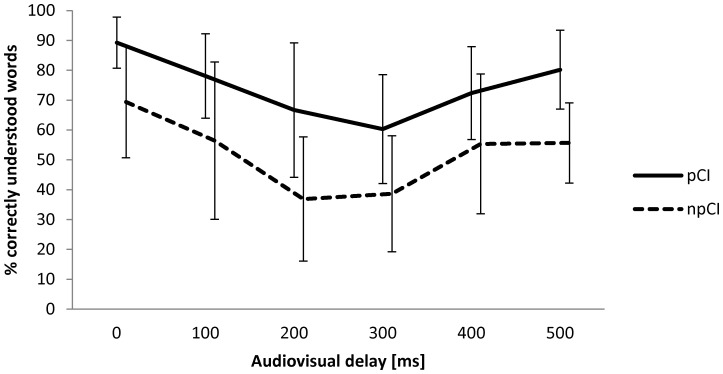
Audiovisual delay.Bimodal mean speech perception (+/−1 SD) is plotted against audio-visual delay (auditory signal proceeds image) for n = 10 proficient (pCI) and n = 11 non-proficient (npCI) CI users. Fusion of incongruent auditory and visual stimuli is not possible after 200 ms for npCI and 300 ms for pCI users. Intelligibility improved again after long AV delays because CI users did not try to fuse both incongruent signals and relied on either one of the stimuli.